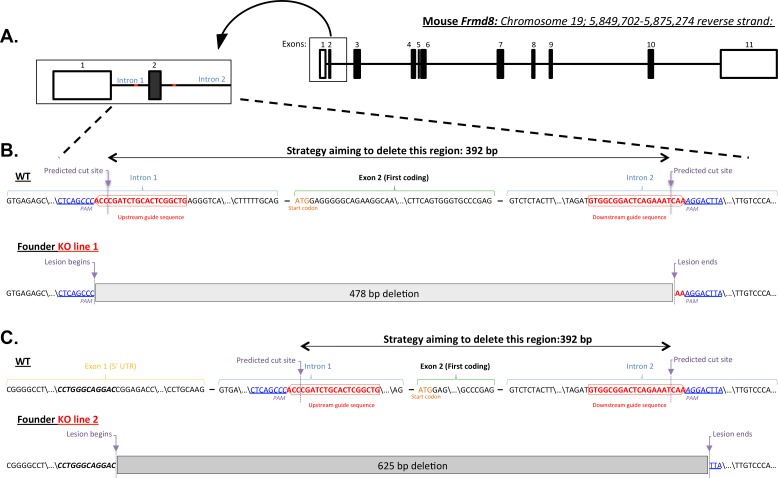
Mouse Frmd8/iTAP gene targeting via CRISPR.(A). Schematic diagram showing the Frmd8 locus. Non-coding exons are denoted by open rectangles, whereas coding exons are shaded black. An enlarged area showing Frmd8 exons 1 and 2 is included to indicate the regions targeted by the CRISPR strategy. (B,C). Detailed maps of the WT and mutant loci of two different Frmd8 KO founder lines that were generated. A pair of gRNAs (indicated in red) was selected to engineer the deletion of the first coding exon of mouse Frmd8 as described in materials and methods. The PAM sequence and the theoretical Cas9 cut sites 3–4 bp from the PAM are indicated. The resulting founder animals were genotyped from tail biopsies and the identity of the lesions revealed by DNA sequencing. Two lines of animals (1 and 2) were established following germline transmission of the mutant alleles from individual founders. (B). KO line 1 contains a 478 bp deletion that removes exon 2 along with parts of introns 1 and 2. (C). KO line 2 contains a larger deletion of 625 bp that starts within the non-coding exon 1, deletes all of intron 1, exon 2 and part of intron 2, as shown. In both cases, the precise nucleotide sequence on the 5’ and 3’ boundaries of the mutant lines is indicated and aligned with the WT genomic sequence. The loss of iTAP at the protein level in both founder lines was confirmed by western blotting.